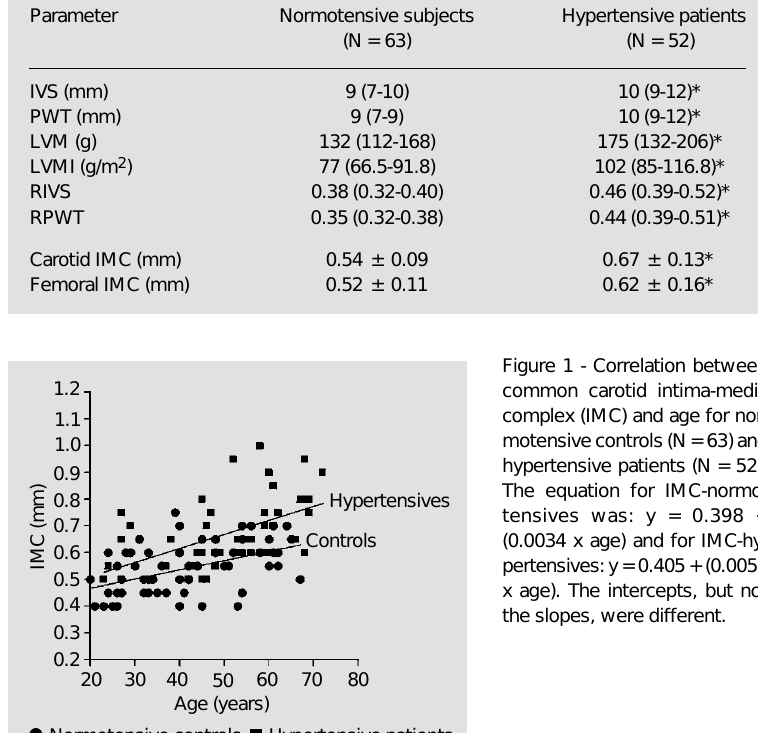
Table 2 - Vascular and cardiac parameters. Cardiac structures are reported as median (confidence interval). Vascular IMC are reported as mean ± SD. *P<0.0001 vs normotensive subjects. IVS, Interventricular septum thickness; PWT, posterior wall thickness; LVM, left ventricular mass; LVMI, left ventricular mass index; RIVS, relative interventricular septum; RPWT, relative posterior wall thickness; ICM, intima-media complex.